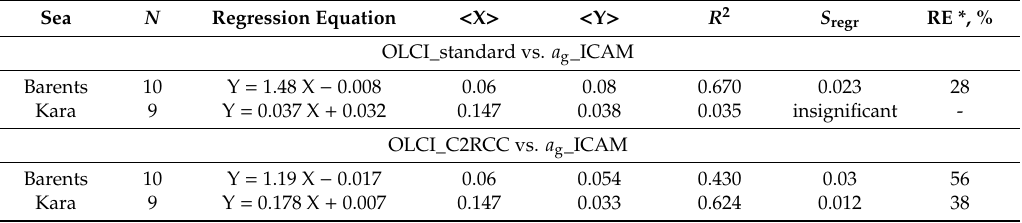
Table 3. Regression parameters of the absorbance values calculated from OLCI data ( a g _olci_std, m − 1 (Figure 5a) and a g _olci_C2RCC (Figure 5b)) versus those measured by ICAM ( a g _icam), m − 1 .